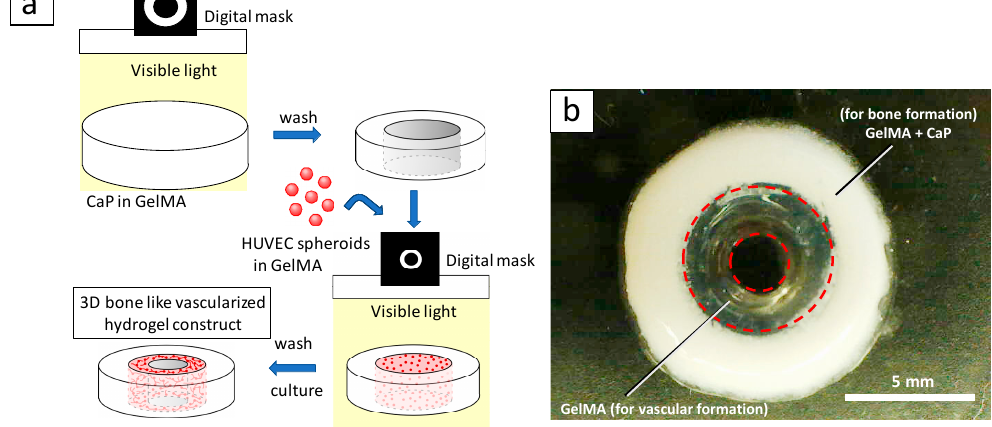
Figure 1. ( a ) Schematic illustration of fabrication process for 3D hydrogel constructs. ( b ) A photograph of 3D hydrogel constructs for vascular and bone formation. Bar = 5 mm.